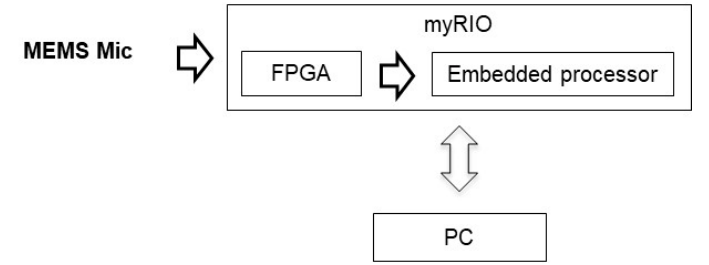
Figure 3. Acoustic system hardware setup.